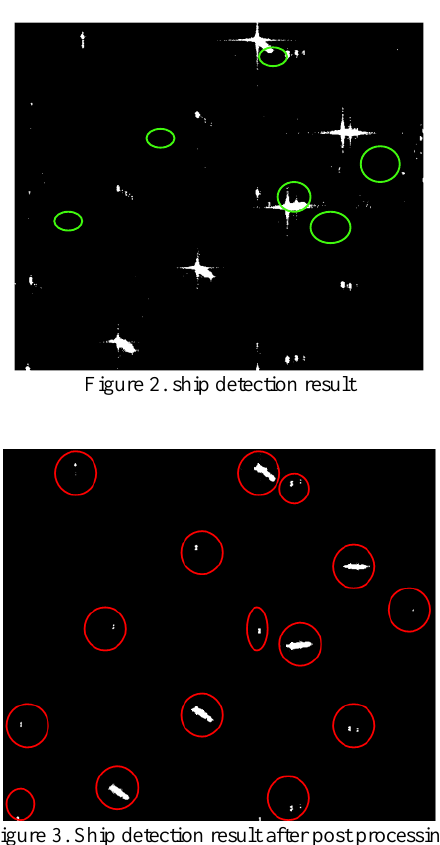
Figure 3. Ship detection result after post